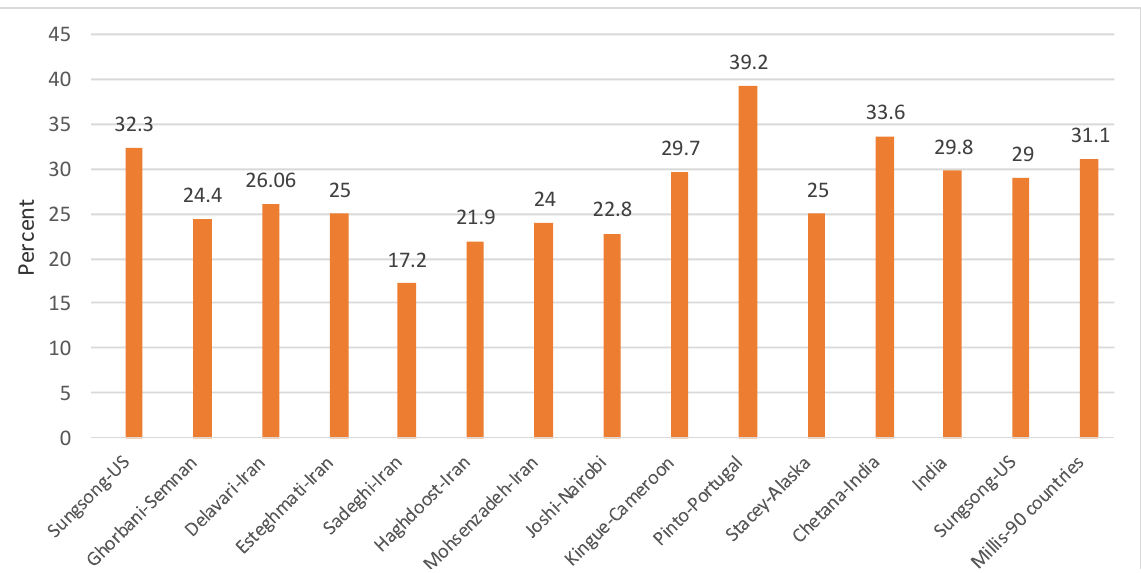
Figure 1: Prevalence of hypertension in some parts of the world compared with this